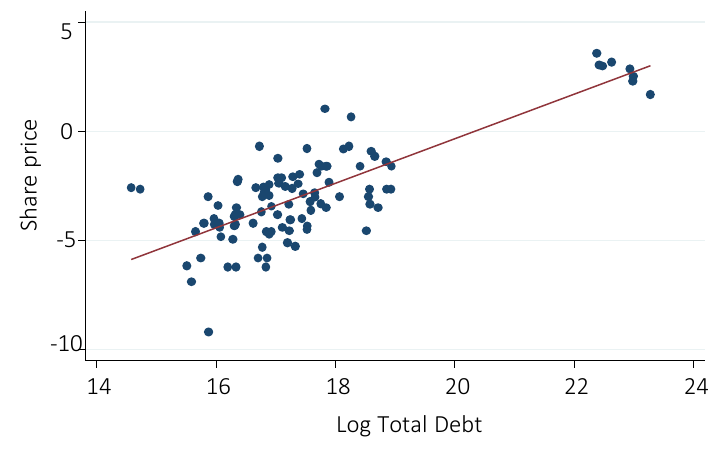
Figure 6. Share price-total